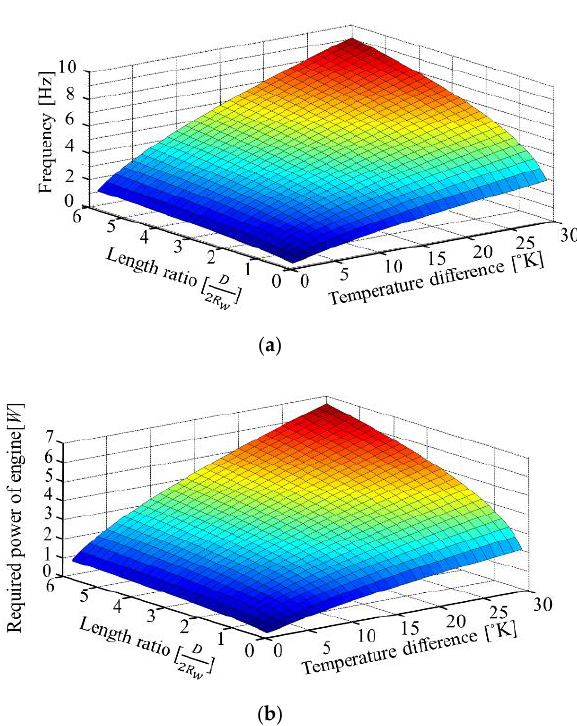
Figure 9. Relationship between the length ratio ( D /2 R w ) and frequency of the wheel at various temperature differences. ( a ) Frequency of the wheel with different length ratios (0 – 6) at various temperature differences ( Δ T = 0 – 30 K). ( b ) Required power of the engine with different length ratios (0 – 6) at different temperature differences ( Δ T = 0 – 30 K).